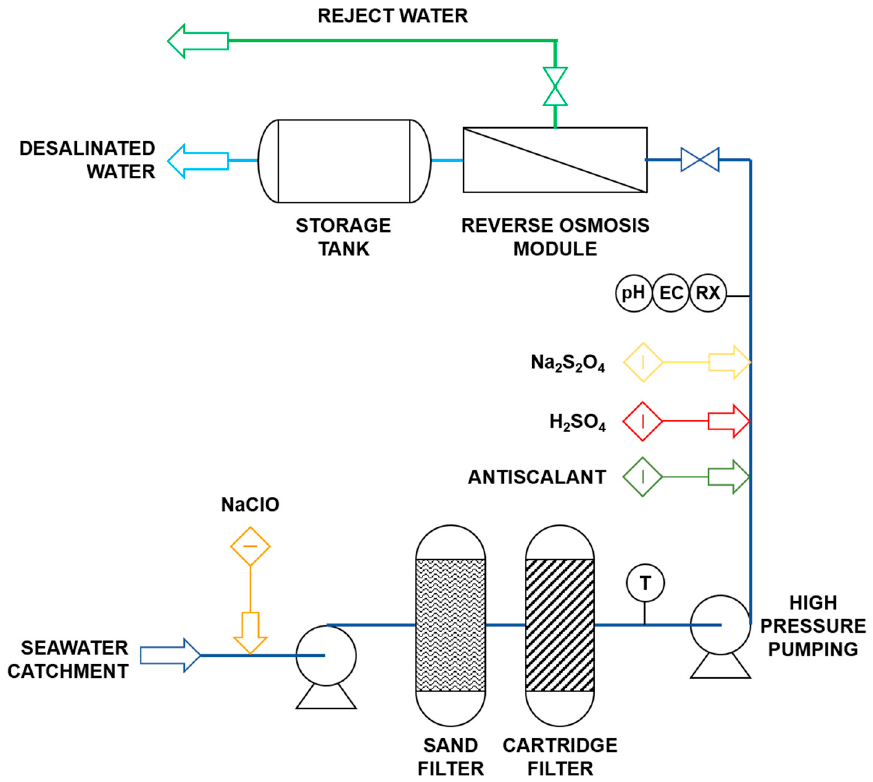
Figure 1. Diagram of the reverse osmosis (RO) pilot system used in the test.